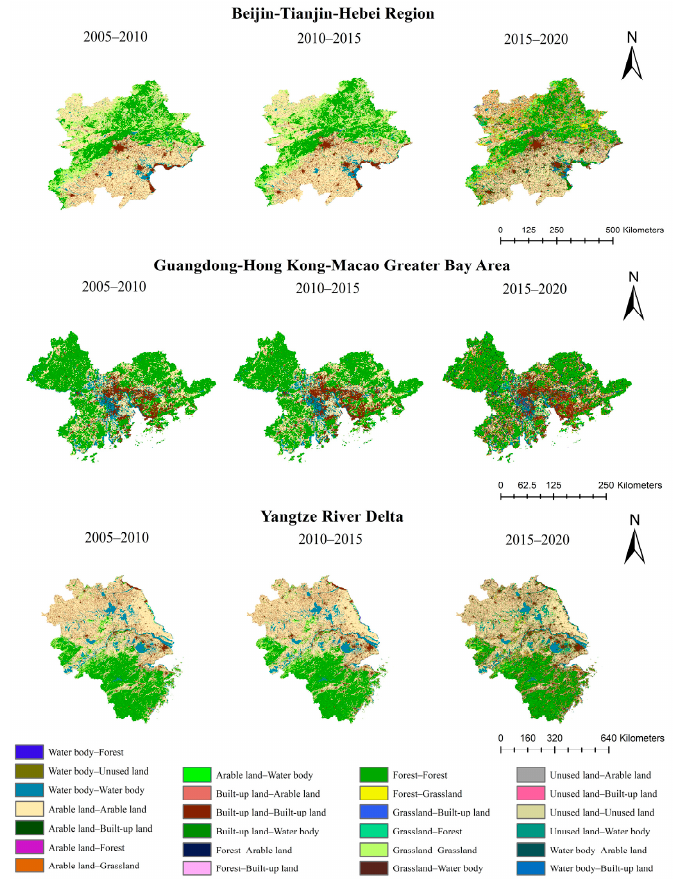
Figure 3. LUCC pattern Change in study areas during 2005–2020.